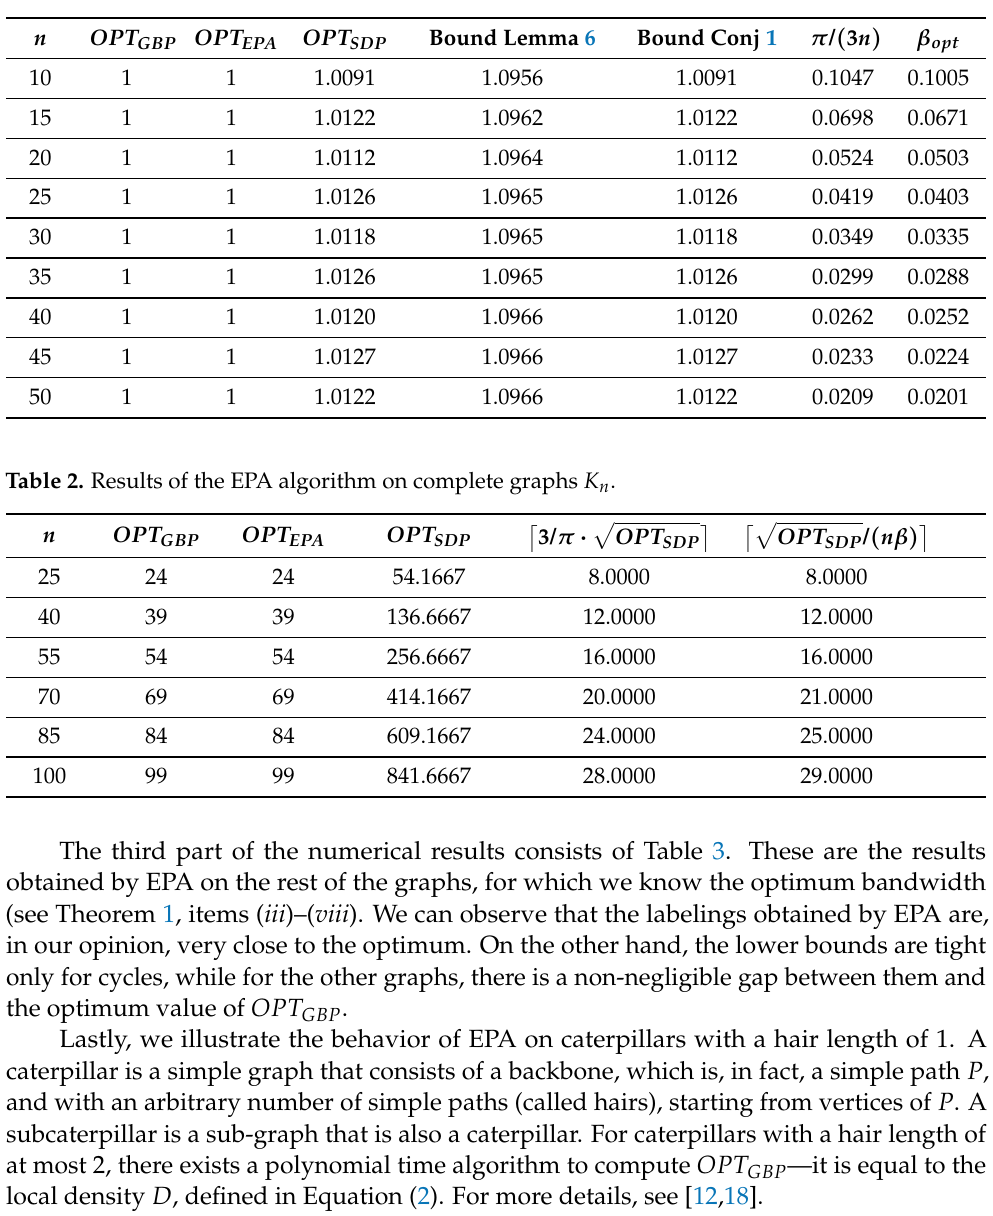
Table 1. Numerical results obtained by the EPA algorithm on simple paths P n .